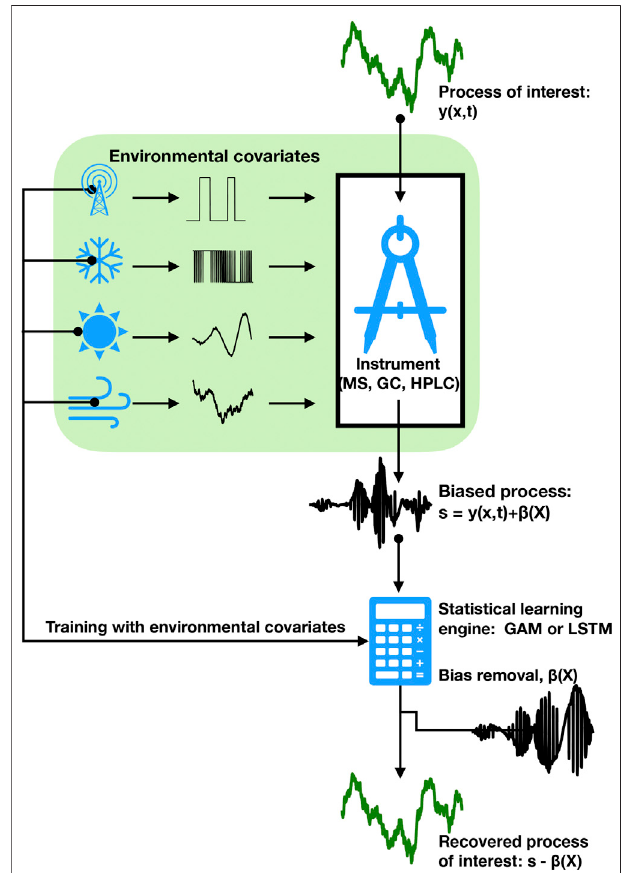
FIGURE 1 | A schematic depiction of the effect of environmental factors on the introduction of bias into in situ chemical instrumentation and the subsequent identi fi cation and removal of bias using environmental covariates to train a statistical learning